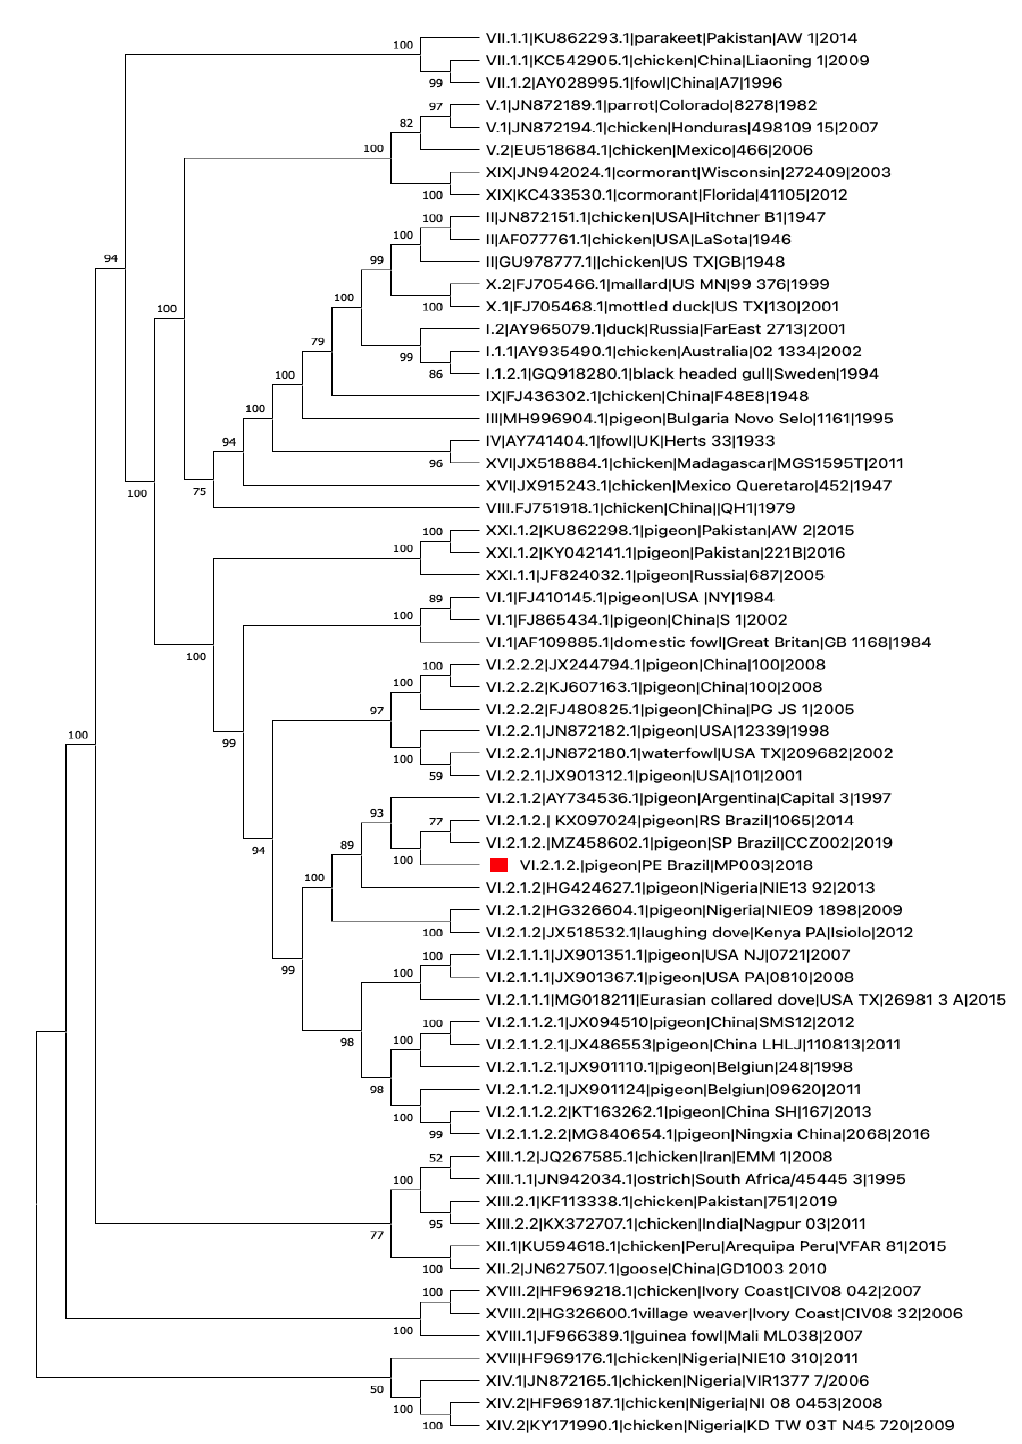
Figure 2. Phylogenetic characterization of NDV/pigeon/PE-Brazil/MP003/2018. Phylogenetic analysis was based on the full-length nucleotide sequence of NDV. The evolutionary history was inferred by using the Maximum Likelihood method and General Time Reversible model. The tree with the highest log likelihood ( − 18,158.31) is shown. Our analysis classified the NDV/pigeon/PE- Brazil/MP003/2018 as genotype VI.2.1.2 strain (highlighted with a red square). The Roman numerals presented in the taxa names in the phylogenetic tree represent the respective sub/genotype for each isolate, followed by the GenBank Accession number, hostname, country of isolation, and year of isolation (if